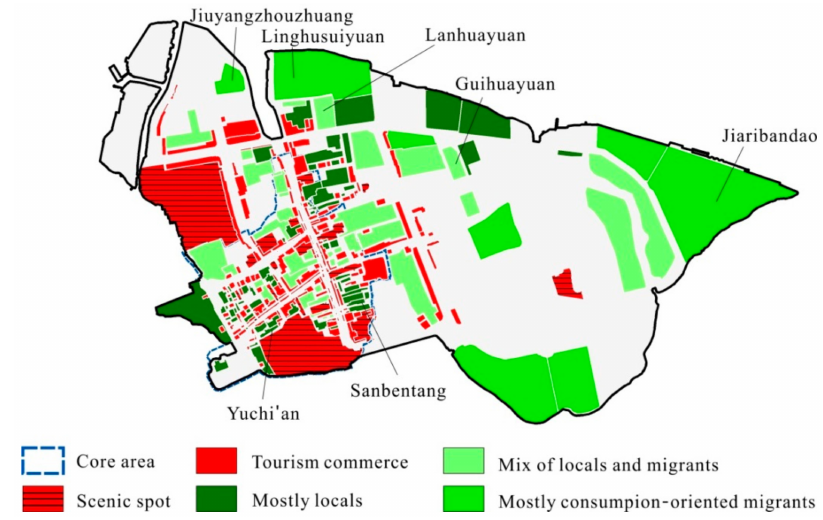
Figure 4. Distribution of residential space in